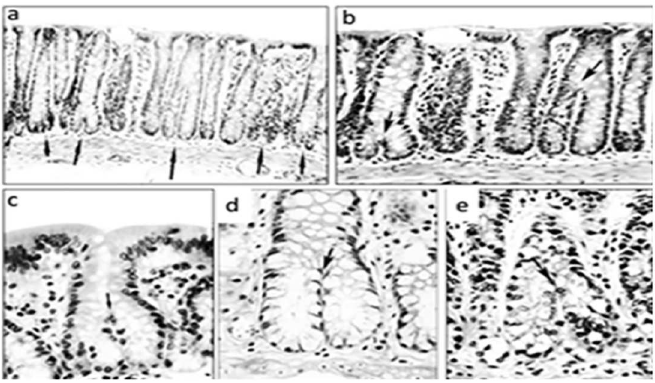
Fig 1. Various stages of normal symmetric colonic crypt fission at arrows (EDTA-treated rats, hematoxylin-eosin, a: x4, b:x10, c, d, e: